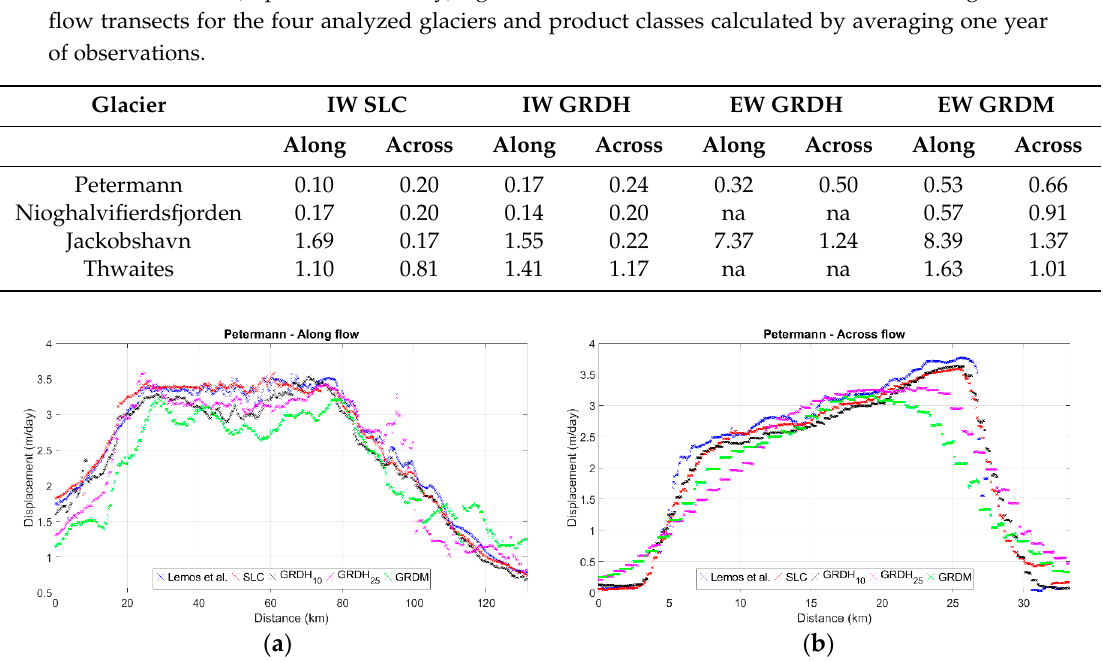
Figure 6. PG, average annual flow speed for reference data (blue curve) and all the analyzed products (IW SLC red curve, IW GRDH black curve, EW GRDH magenta curve, EW GRDM green curve). ( a ) Along flow speed. ( b ) Across flow speed.